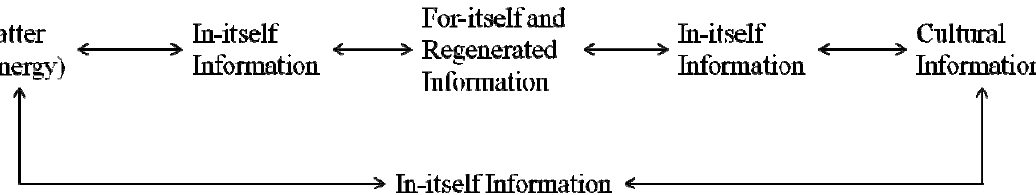
Figure 3. Complex synthetic picture of the world consisting of a material world and three information worlds